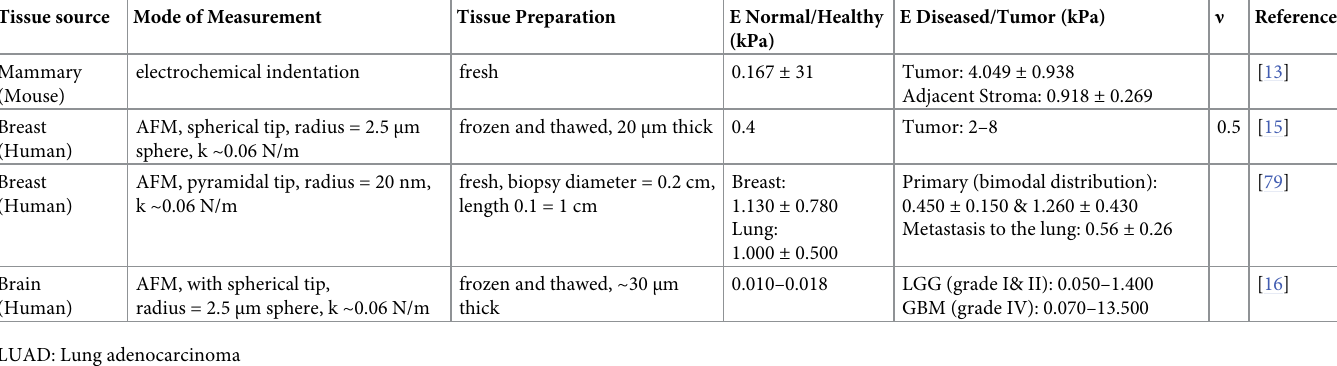
Table 2. Reported Mechanical Properties of Tumor